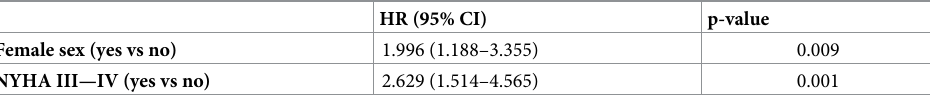
Table 6. Predictors of all-cause of 1- year mortality and rehospitalization in AHF patients (multivariable